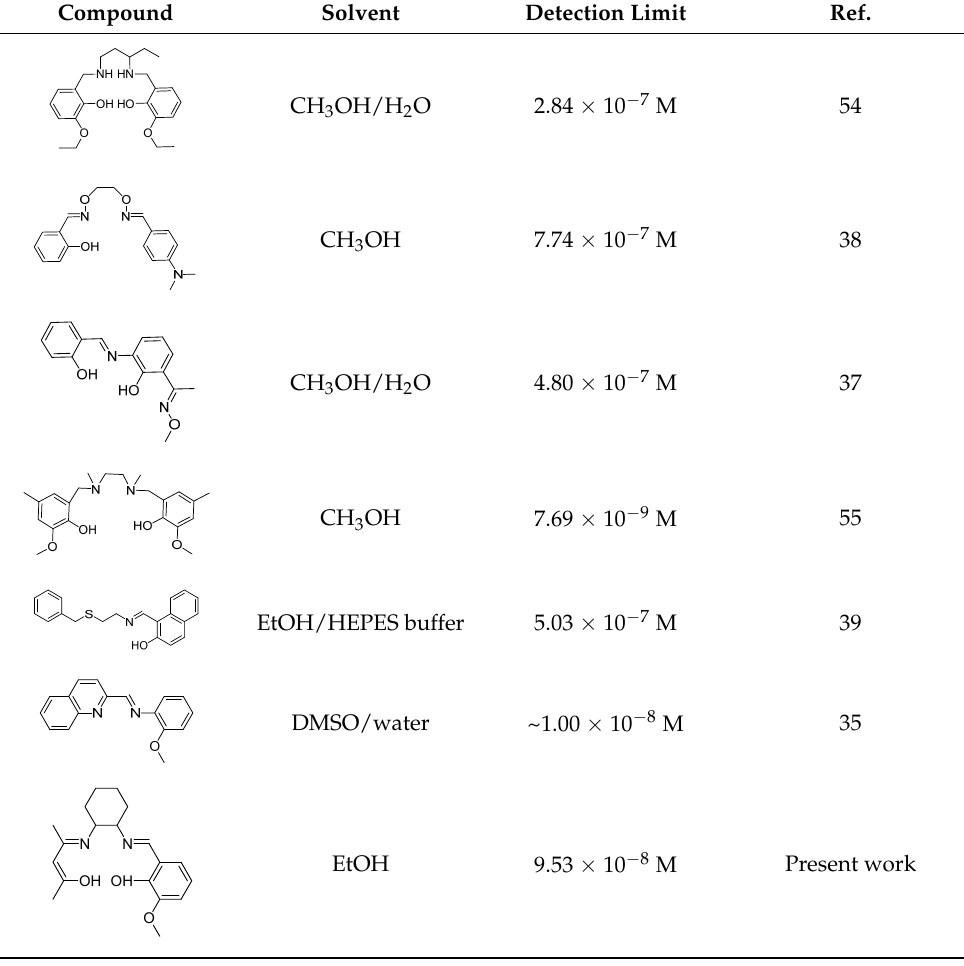
Table 1. Comparison of various fluorescent sensors for Zn 2+ .